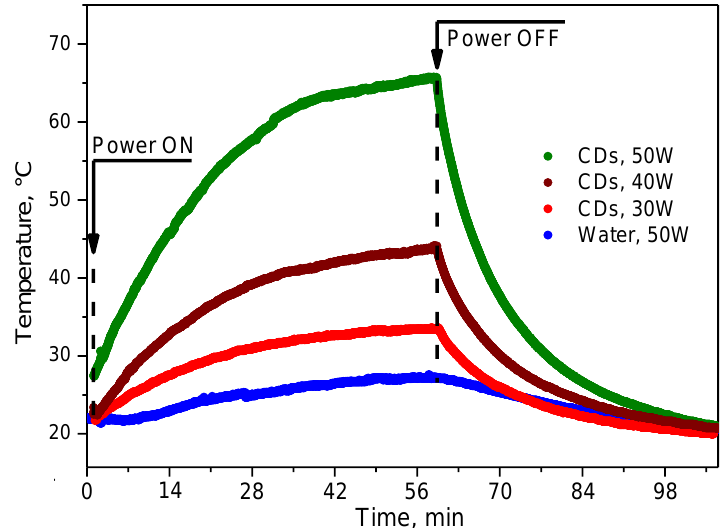
Figure 3. RF-induced heating/cooling of colloidal solutions of O, N-CDs in water at the RF generator powers of 50, 40, and 30 W and water at the RF generator power of 50 W.